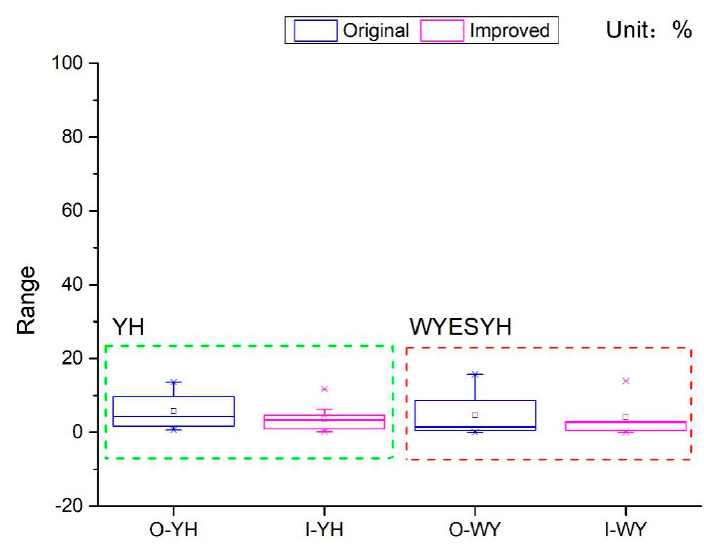
Figure 10. The maximum water shortage range of two typical units.